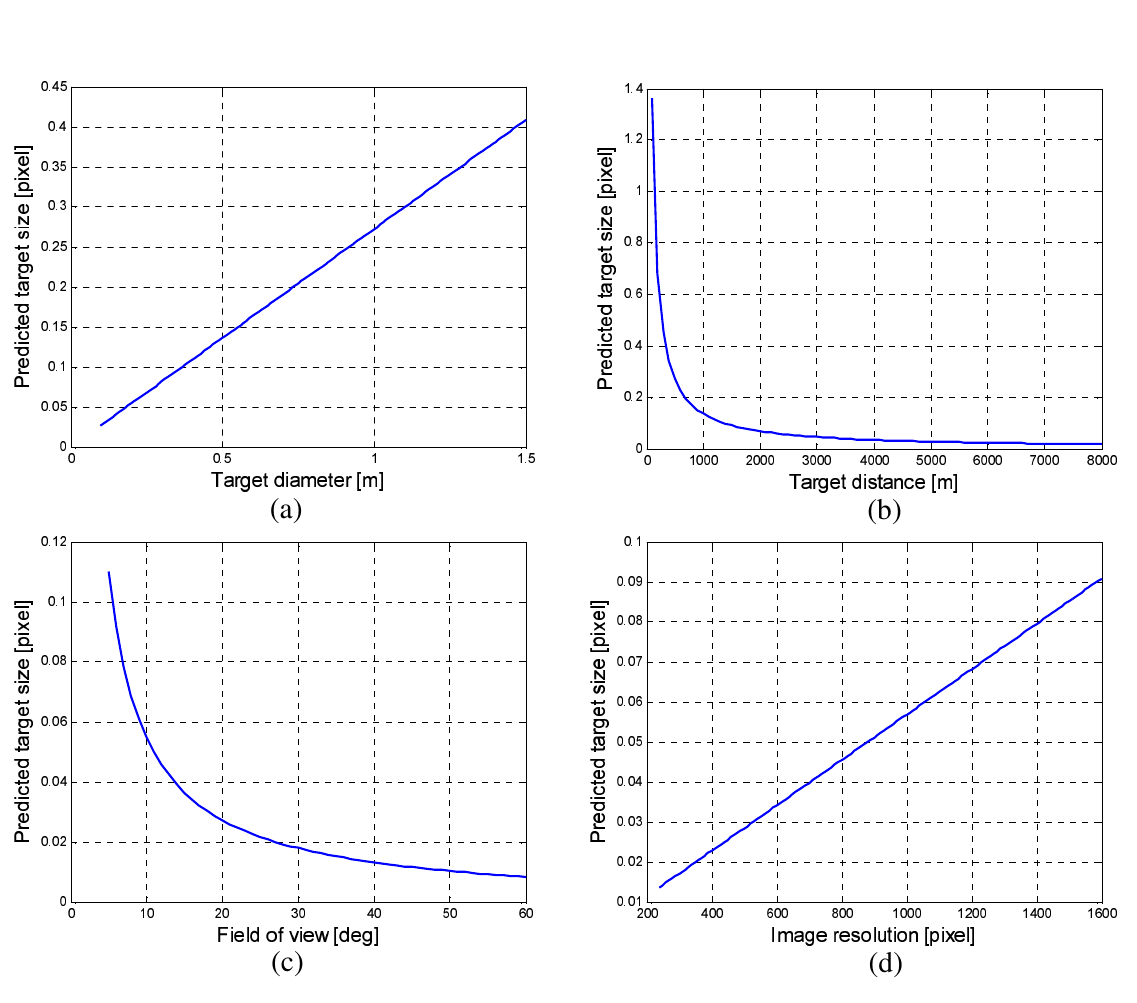
Figure 4. Analysis of an imaged target size depending on ( a ) target diameter; ( b ) target distance; ( c ) field of view and ( d ) image